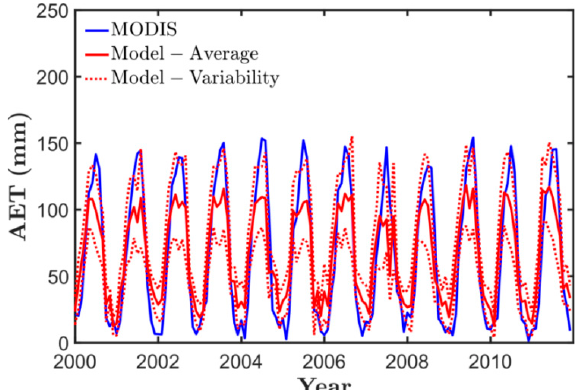
Figure 7. Validation of monthly AET for the whole watershed. The model average and variability represents, respectively, spatially averaged monthly flux and the spatial standard deviation.